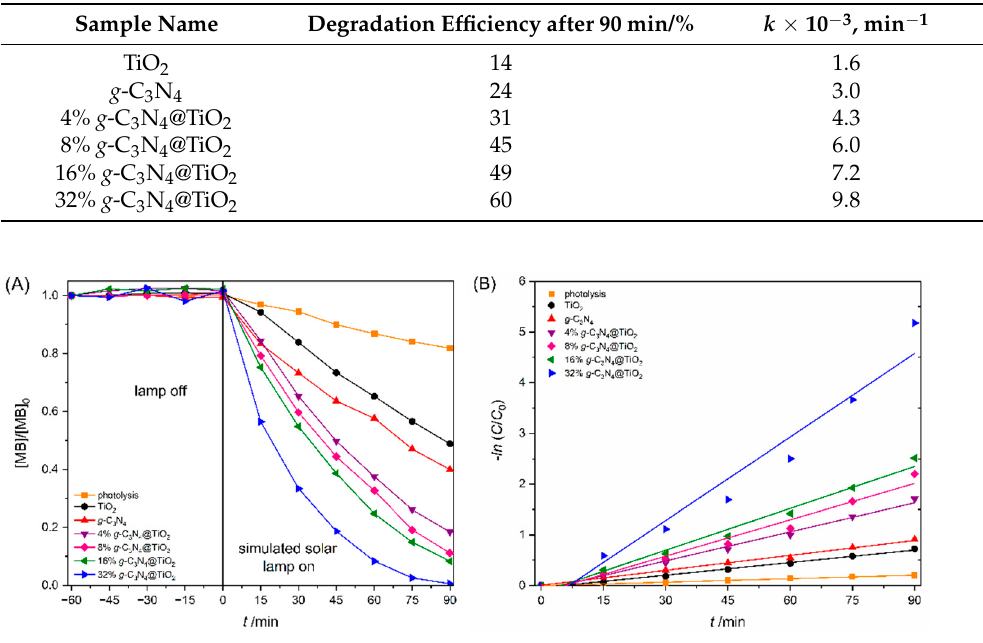
Figure 6. ( A ) Adsorption and photocatalytic activities of the prepared photocatalysts and ( B ) plotted first-order kinetics of MB degradation under simulated solar irradiation. Table 3. The values of degradation efficiency of MB under simulated solar irradiation and first-order rate constant ( k